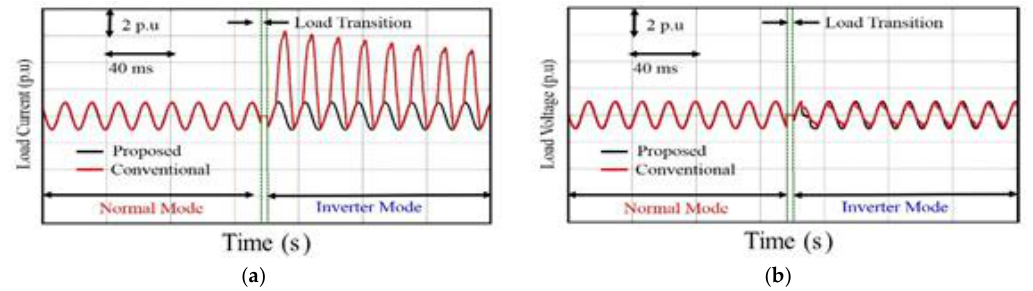
Figure 22. ( a ) Load current; and ( b ) load voltage for the conventional and proposed single-phase offline UPS topologies when the inverter voltage is injected at 300°.